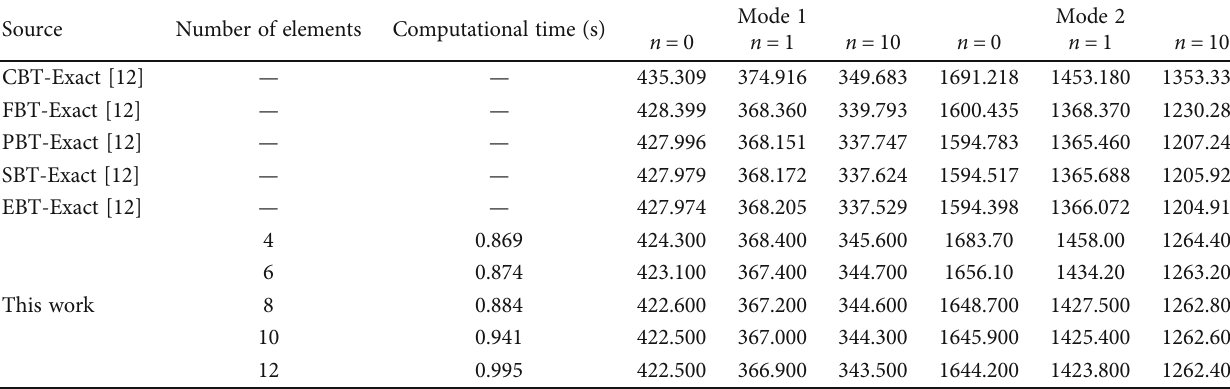
Table 1: The fi rst two natural frequencies (Hz) of the piezoelectric FGM, S-S ( L = 1 m , L / h = 10 ). Source Number of elements